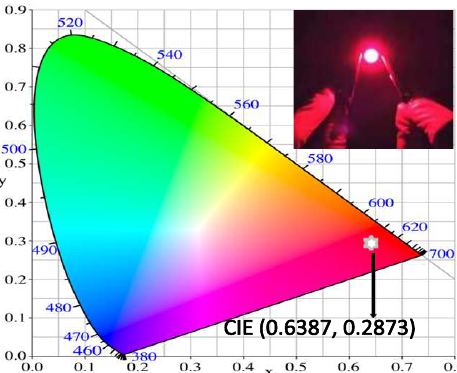
Figure 7. CIE chromaticity coordinates of the sample. The illustration shows the LED device in a 450nm chip package.